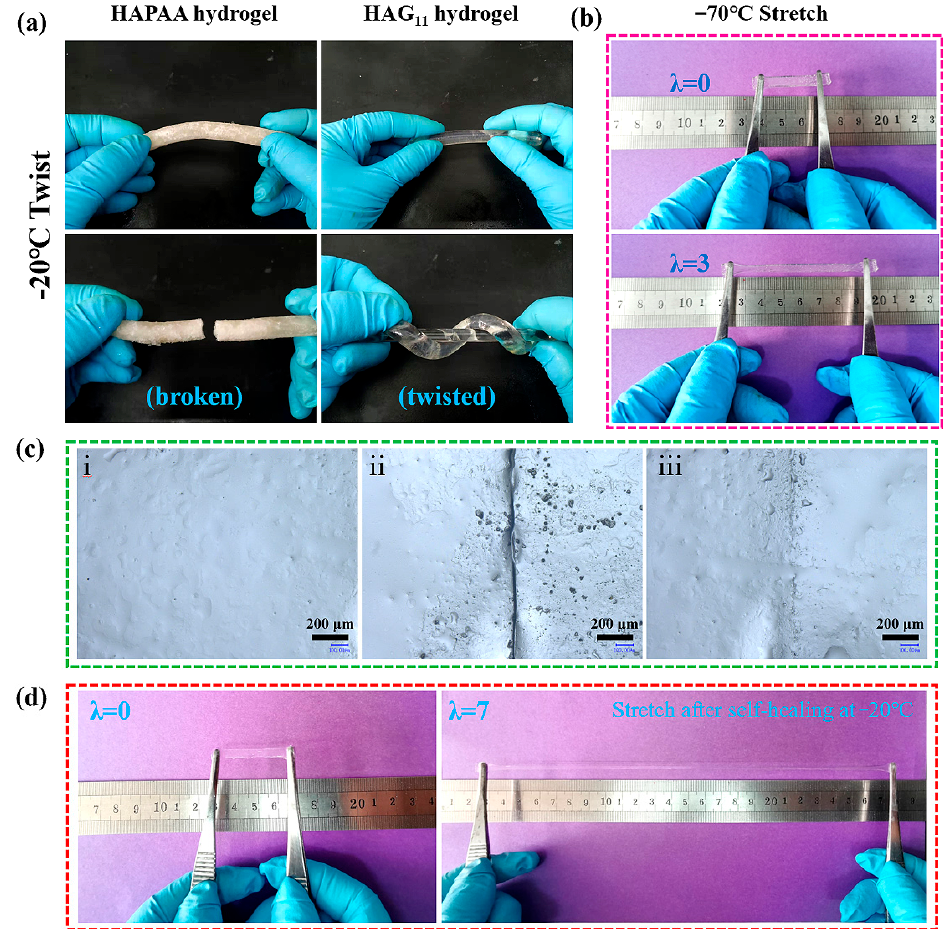
Figure 2. ( a ) Photos of the twisted HAPAA and HAG 11 hydrogels at − 20 °C. ( b ) The original and stretched HAG 11 hydrogel at − 70 °C. ( c ) Microscope images of HAG 11 hydrogels: (i) original, (ii) cutting off and being contacted immediately, and (iii) self-healing for 3 days at − 20 °C. ( d ) Photos of the original and the self-healed HAG 11 hydrogels for 3 days at − 20 °C.